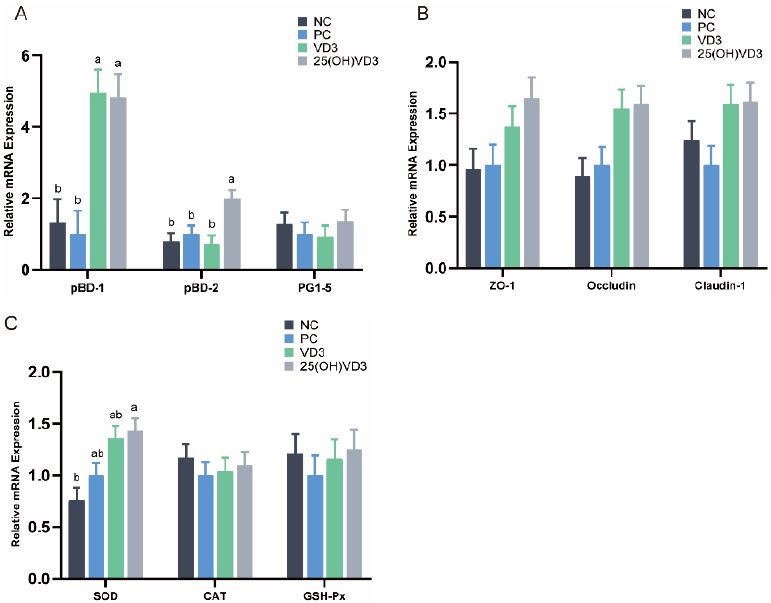
Figure 4. The relative mRNA expressions in the weaned piglets’ ileum. ( A ): The mRNA expression of host defense peptides (pBD-1, pBD-2, PG1-5). ( B ): The mRNA expression of tight junction pro- teins (ZO-1, Occludin, Claudin-1). ( C ): The mRNA expression of antioxidases (SOD, CAT, GSH-Px). Note: Different letters on the top of the column indicate significant differences ( p < 0.05), n = 6. NC, negative control; PC, positive control; VD3, vitamin D 3 ; 25(OH)VD3, 25-hydroxyvitamin D 3 .